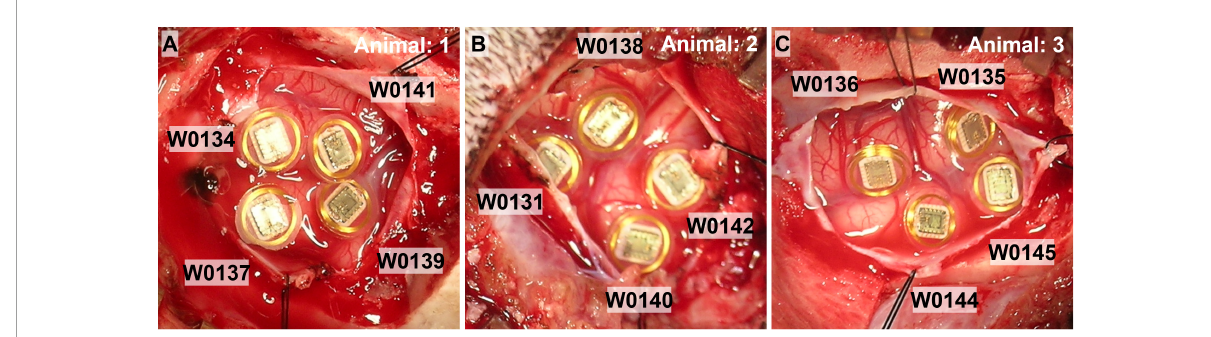
FIGURE3 Photographs of the four WFMA devices after implantation in each of the n = 3 animal subjects. (A) Animal 1, IDs: W0134_3_198, W0137_58_201, W0139_65_203, and W0141_44_205. (B) Animal 2, IDs: W0131_52_195, W0138_90_202, W0140_12_204, and W0142_14_206. (C) Animal 3, IDs: W0135_7_199, W0136_113_200, W0144_97_208, and W0145_109_209.